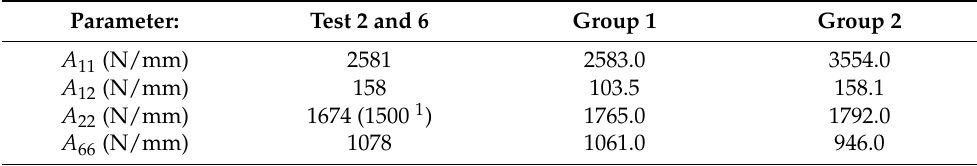
Table 4. The components of A matrix.